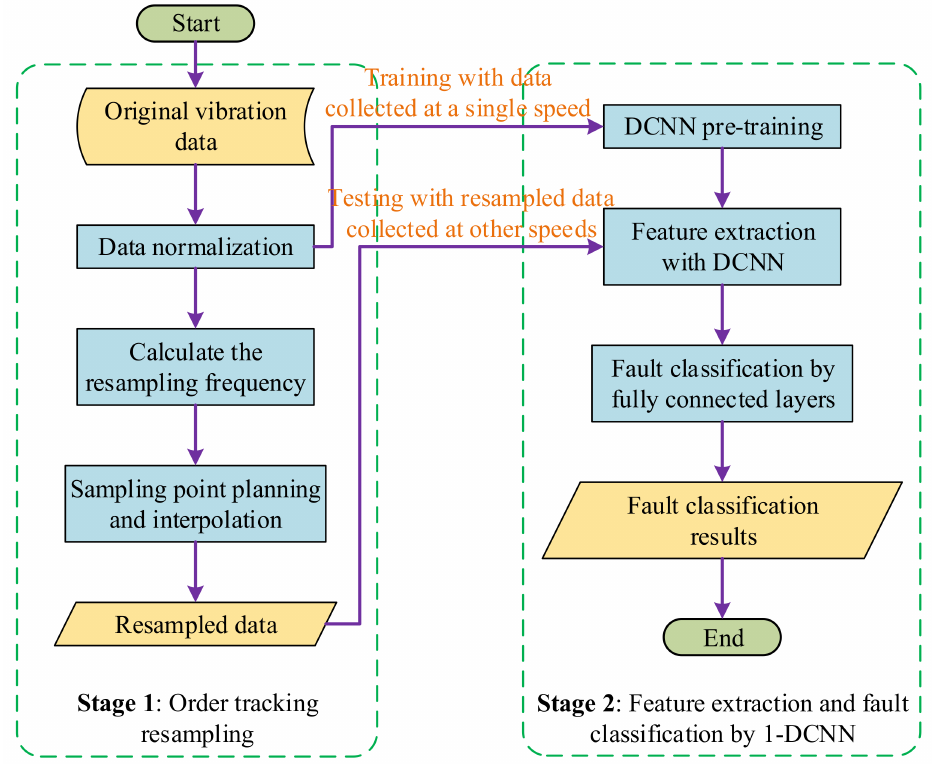
Figure 2. The flow chart of the proposed two-stage, intelligent diagnosis